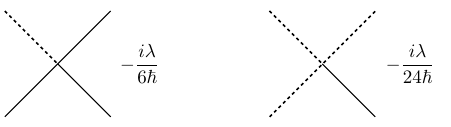
Figure 9 . Feynman propagators, with the solid line being the h (cid:30) cl (cid:30) cl i 0 propagator, and the dash- solid line being the h (cid:30) q (cid:30) cl i 0 propagator.